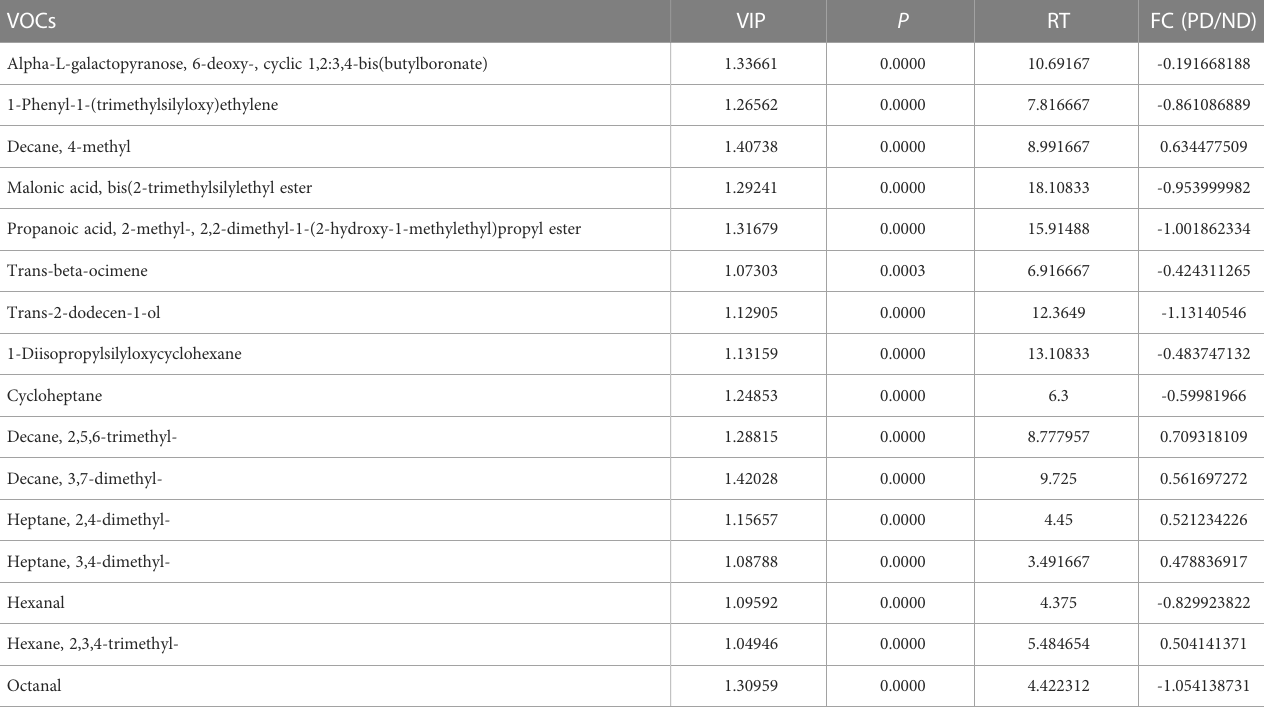
and six were in the PD group. In the two-dimensional PCA score diagram, data from the two groups showed a good separation trend (Figure 1A). When using a single prediction component and three orthogonal components, the PLS-DA score chart displayed the data of the two groups and also had a good separation effect (Figures 1B, C). Two hundred iterations were performed to test the supervision TABLE 3 Differential metabolites in blood VOCs of pregnant women with GDM.